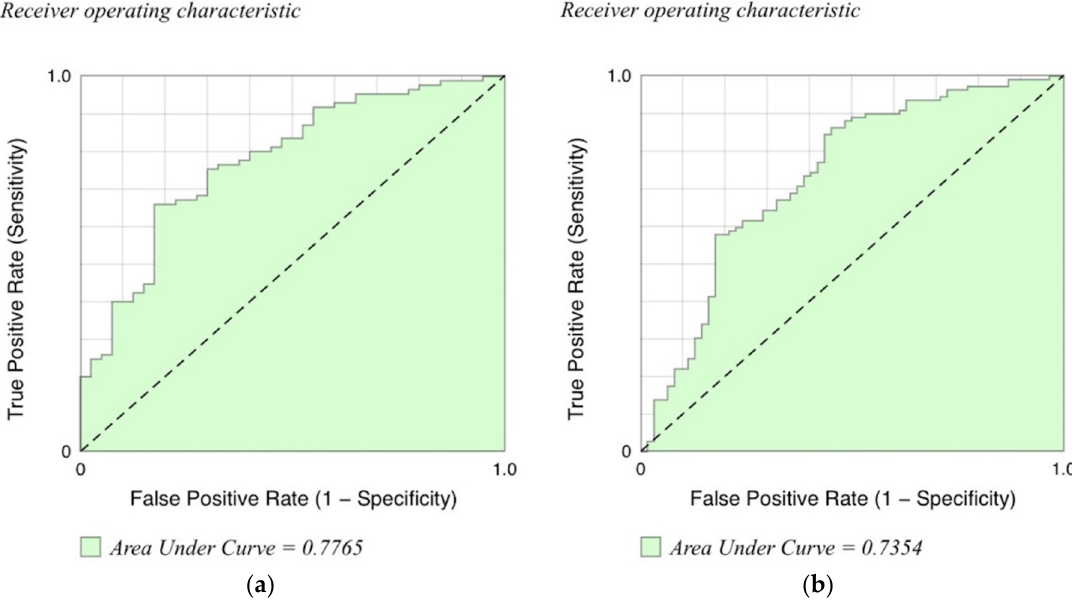
Figure 3. Receiver operating characteristic graphs in the diagnosis of idiopathic pulmonary fibrosis for the derivation ( a ) and validation ( b ) cohorts. Table 4. Multivariable linear correlation analysis of CALIPER variables relative to percent predicted forced vital capacity (FVC) and diffusing capacity of the lungs for carbon monoxide (DLCO) across two tertiary medical centers (labeled derivation and